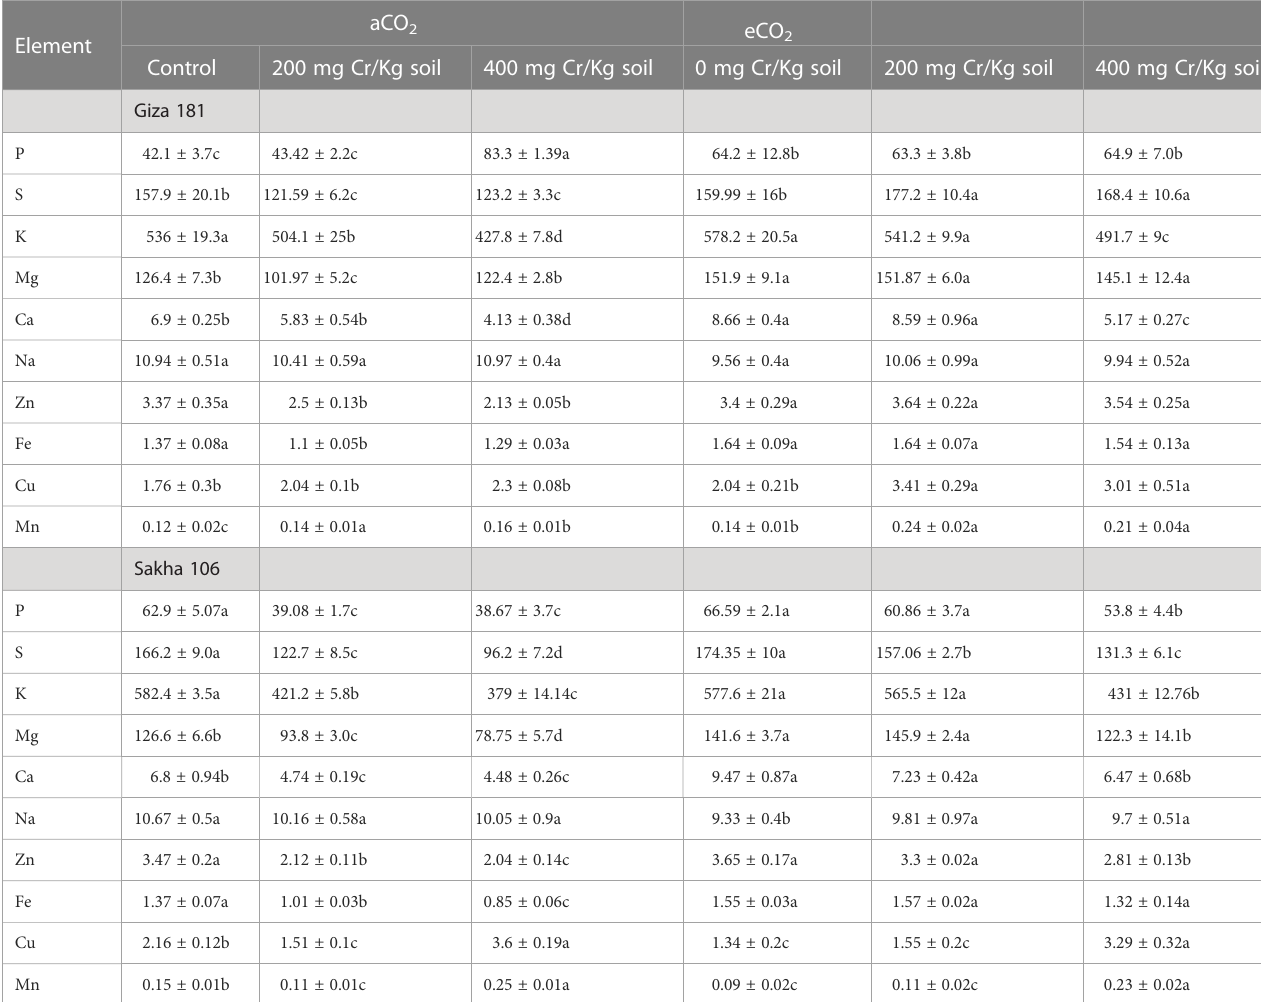
TABLE 1 Effect of Chromium (Cr) exposure on elemental composition of rice grains produced under either aCO 2 (410 ppm) or eCO 2 (620 ppm).